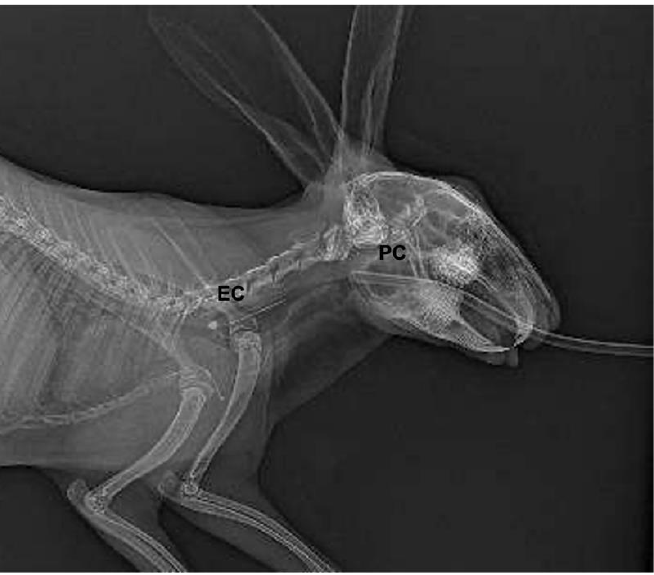
Figure 2. Radiographic image of a rabbit with the ST inserted. EC—oesophageal cuff within the oesophageal lumen; PC—proximal cuff in the oral